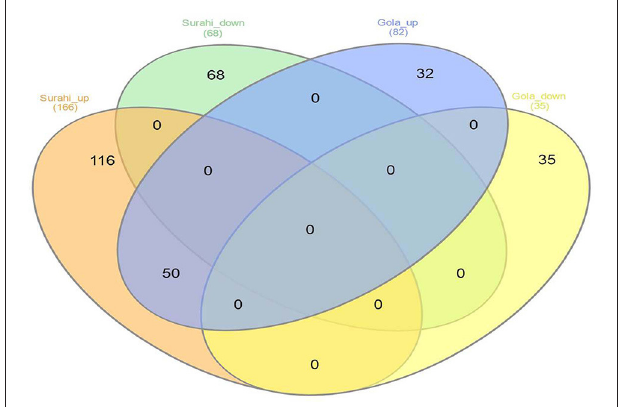
FIGURE 2 | Venn diagram showing differentially expressed ESTs in “Gola” and “Surahi” cultivars of guava under drought stress.